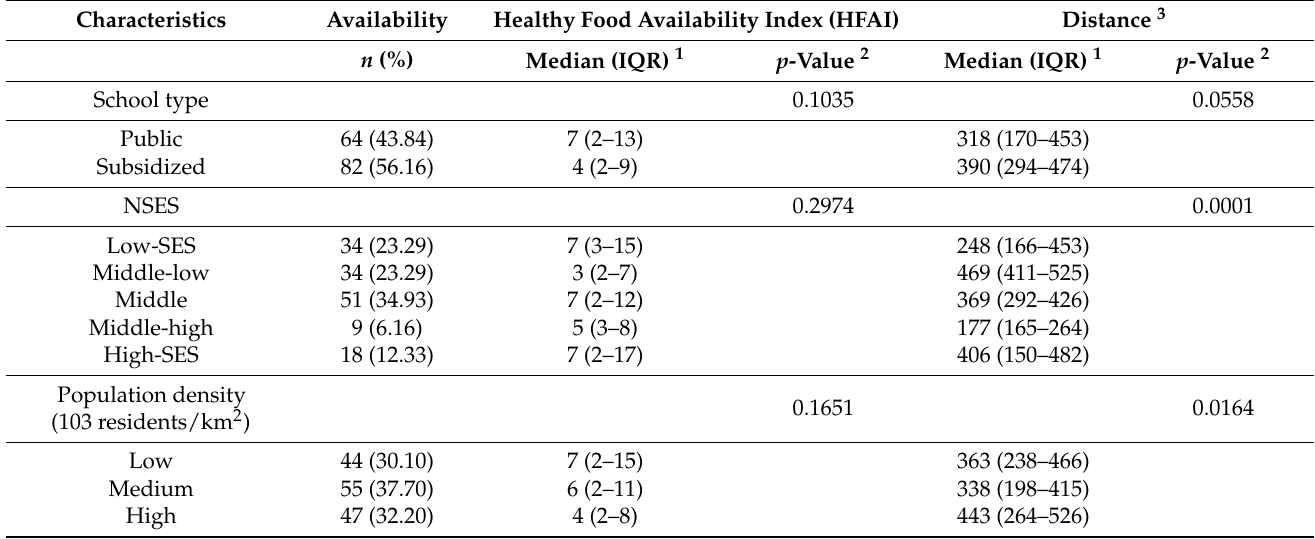
Table 2. Counts, Healthy Food Availability Index (HFAI), and distance (m) to unhealthy retailers ( n = 146) across schools citywide (Barcelona, 2019).